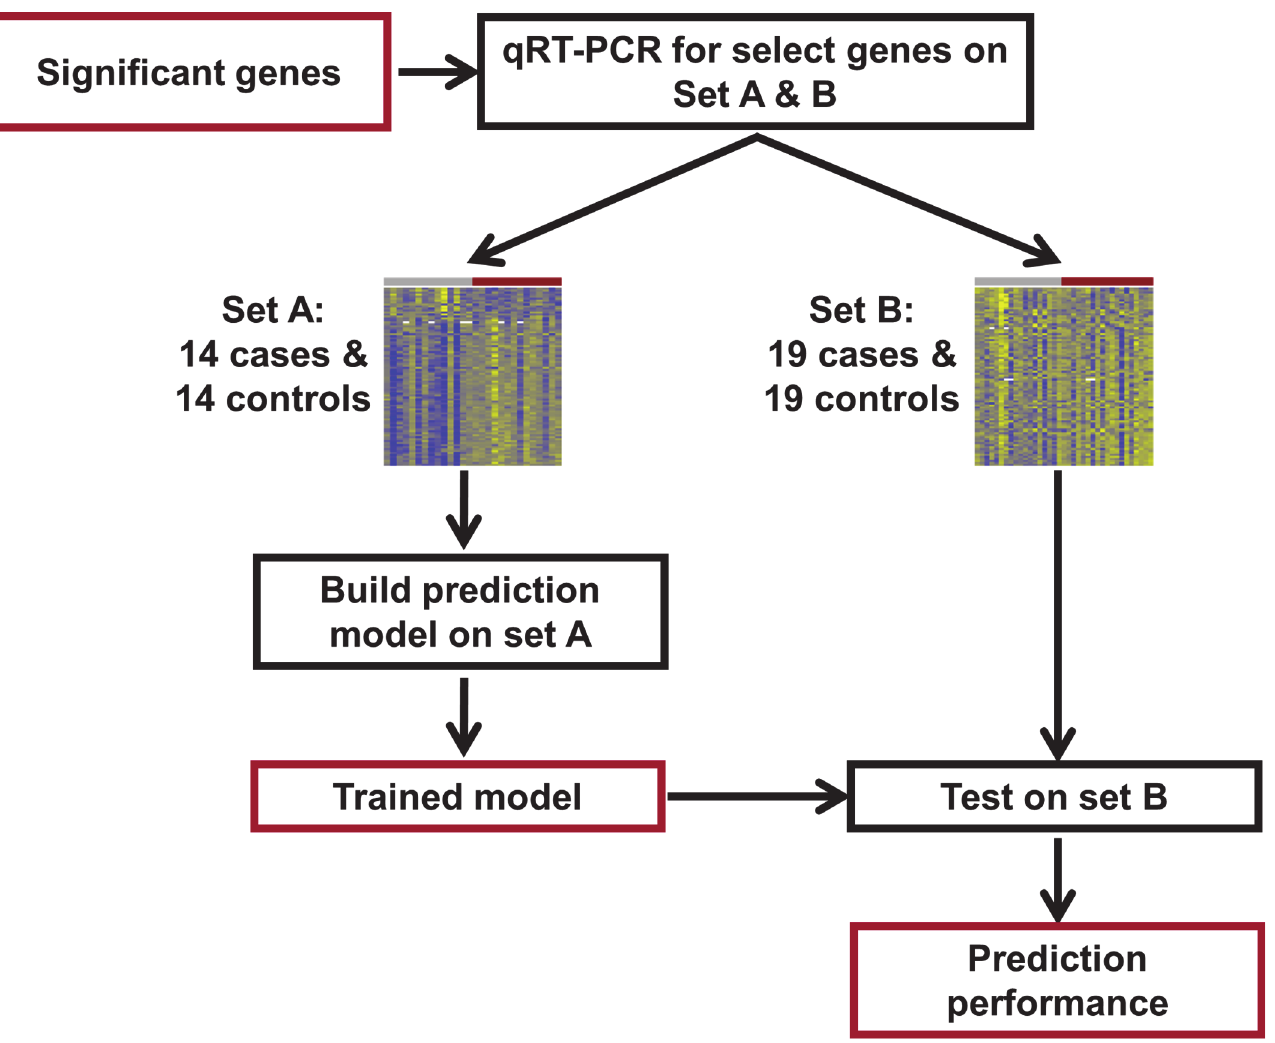
Fig 2. qRT-PCR study flow diagram. Differentially expressed genes identified from the microarray study were profiled using qRT-PCR for validation and construction of a multi-gene disease classifier using an extended set of 33 cases and 33 controls. Set A was used to build the prediction model and then this model was tested on set B, consisting of 19 cases and 19